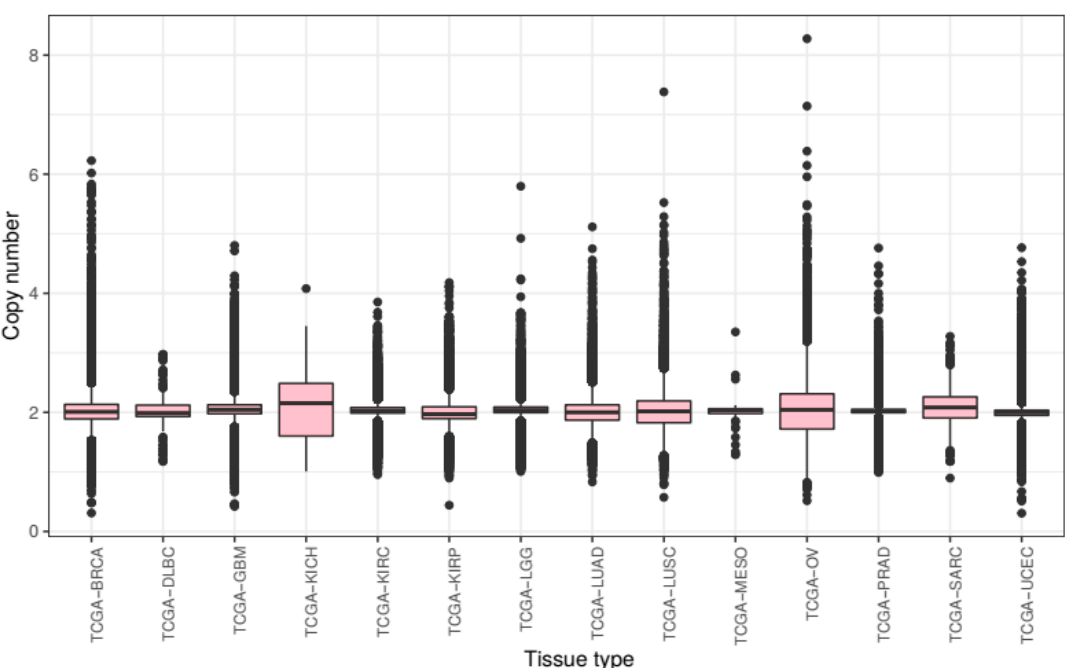
Figure 1. Chromosomal copy number by tissue type—A box-plot summarising mean genome-wide copy number for all samples in the 14 tissue types featured in our pan-cancer dataset. Copy number values were converted from segment mean sourced via TCGA / GDC data. A legend for the featured tissue types is available in the methods section.